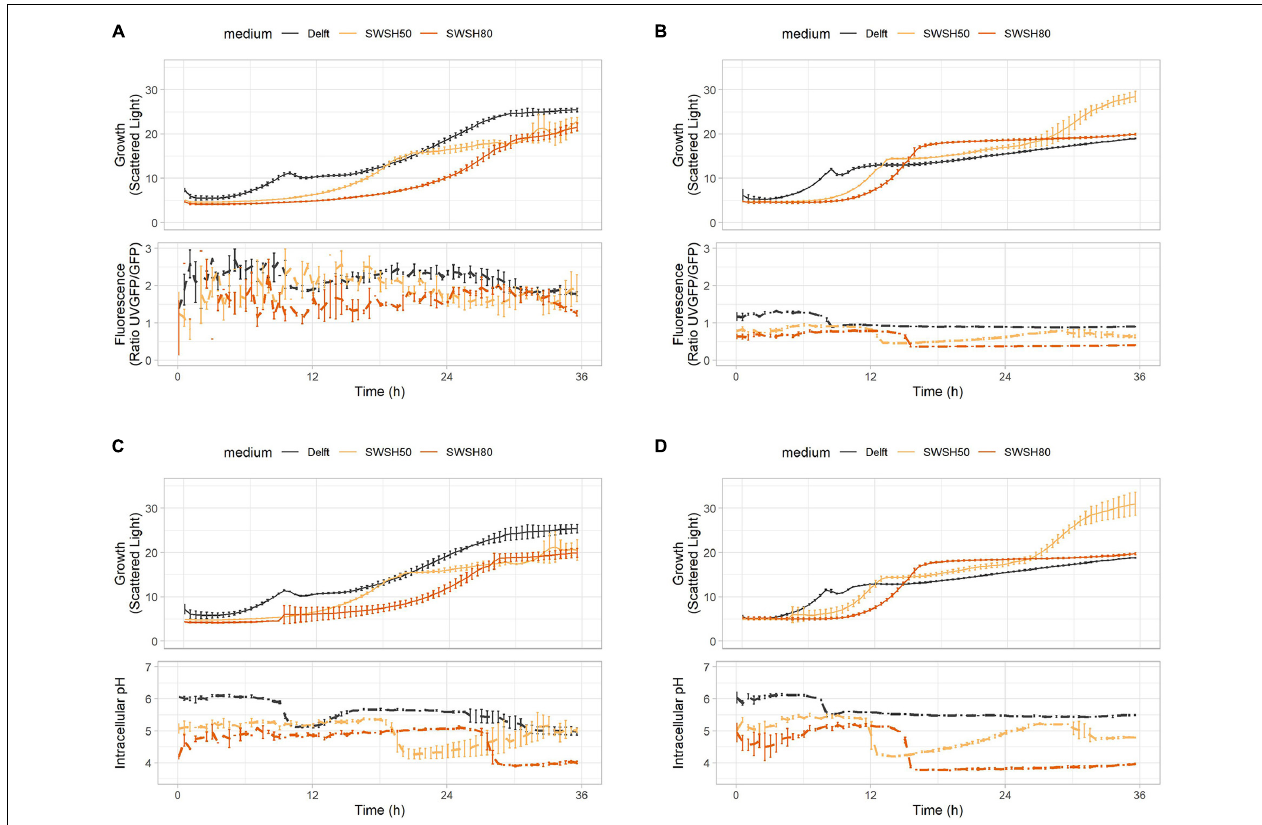
FIGURE 7 | ATP production and intracellular pH during growth in synthetic wheat-straw hydrolysate (SWSH). (A,B) Growth curves and ATP concentration for (A) CEN.PK113-7D and (B) Ethanol Red strains harboring the QUEEN-2m biosensor. (C,D) Growth curves and intracellular pH for (C) CEN.PK113-7D and (D) Ethanol Red strains harboring the sfpHluorin biosensor. Cells were grown in Delft medium (black line), SWSH diluted at 50% with Delft medium (SWSH50; orange line), and SWSH diluted at 80% with Delft medium (SWSH80; red